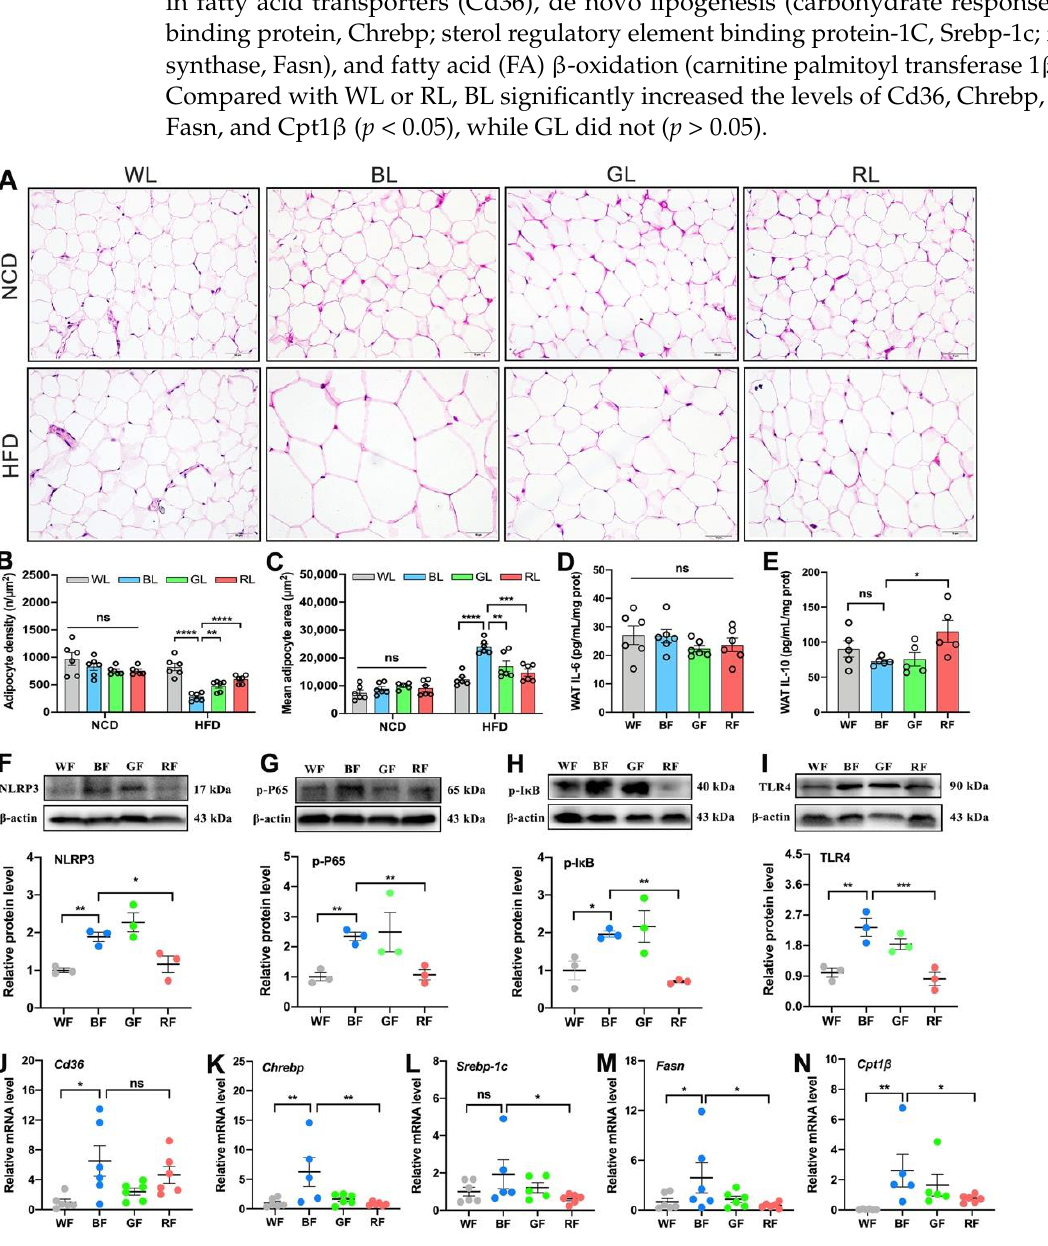
Figure 2. Influences of monochromatic light exposure on WAT hypertrophy and inflammation in mice. ( A ) H&E staining of the Epi- WAT (scale: 50 μm). ( B ) Adipocyte density ( n = 6). ( C ) Mean adipocyte size ( n = 6). ( D , E ) Concentrations of IL-6 and IL-10 in the Epi-WAT ( n = 6). ( F – I ) Relative protein expression levels of NLRP3, p-P65, p- IκB, and TLR4 in the Epi -WAT ( n = 3). ( J – N ) Relative mRNA expression levels of Cd36, Chrebp, Srebp-1c, Fasn, and Cpt1β ( n = 6). The circles represent the number of samples. The results are presented as the means ± SEM. * p < 0.05, ** p < 0.01, *** p < 0.001, **** p < 0.0001.